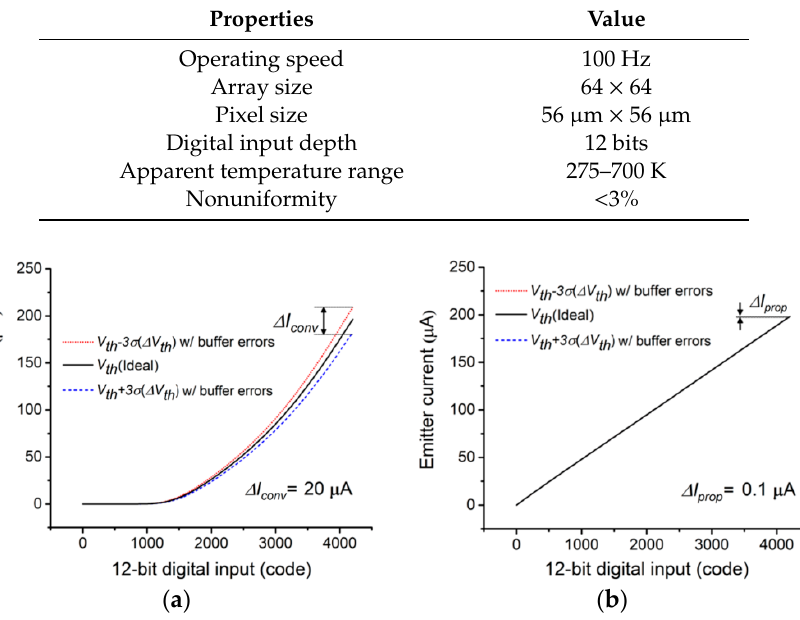
Table 1. Target infrared scene projector (IRSP) properties.